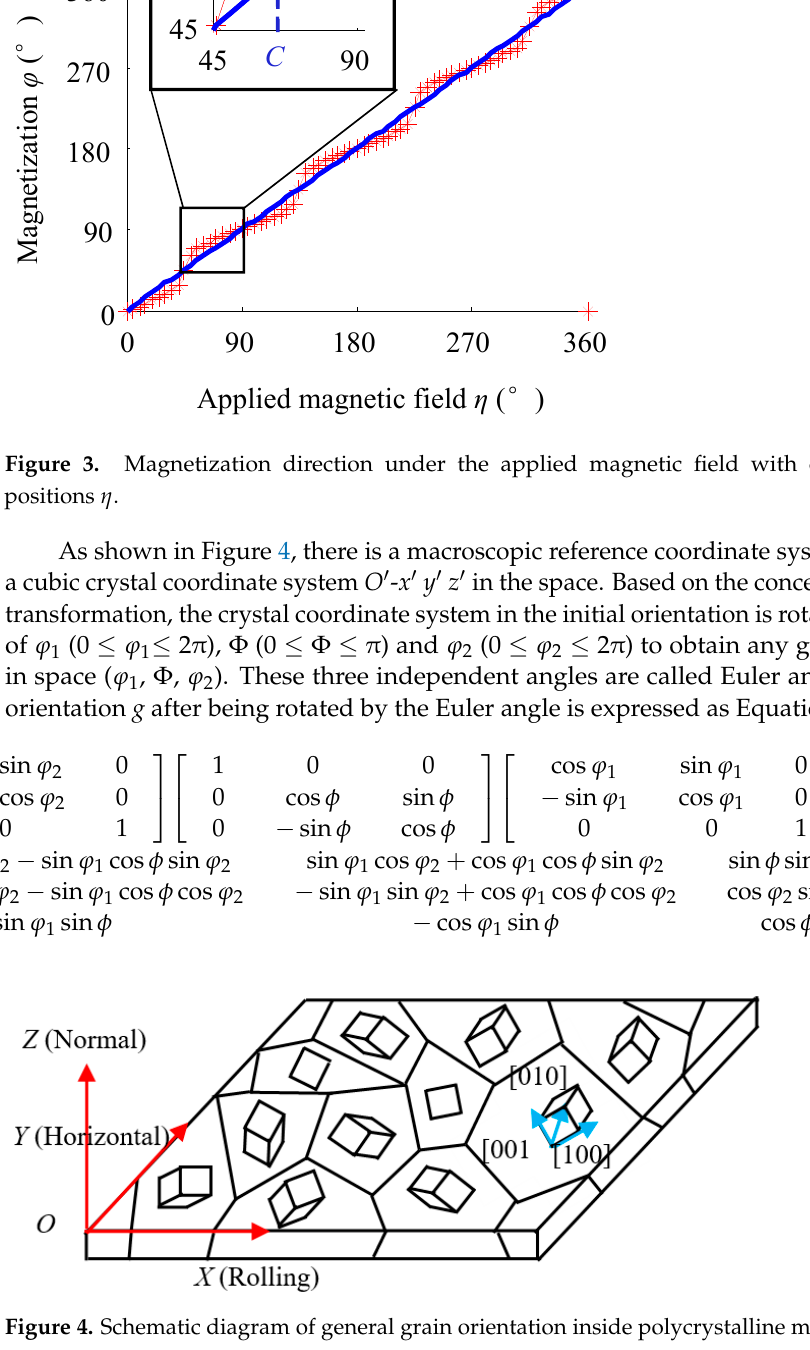
Figure 3. Magnetization direction under the applied magnetic field with different angular positions η .